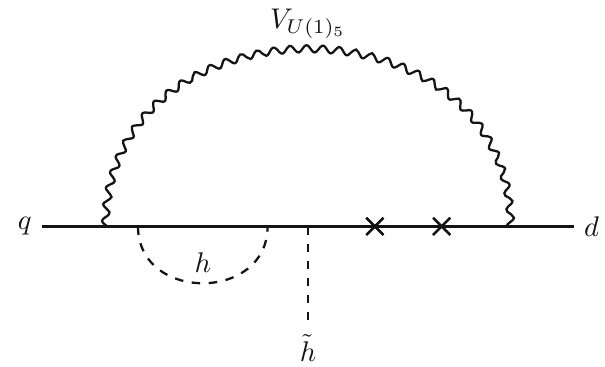
Fig. 2 Example of 2-loop diagram with heavy gauge fields